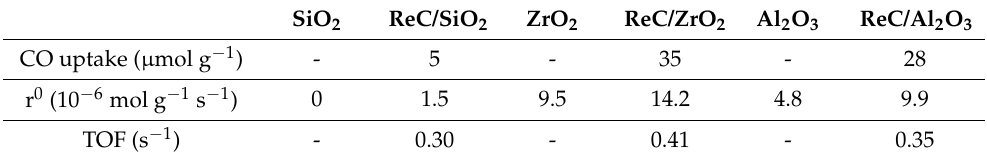
Table 3. CO uptake and initial rate of guaiacol conversion obtained at 350 ◦ C. SiO 2 ReC/SiO